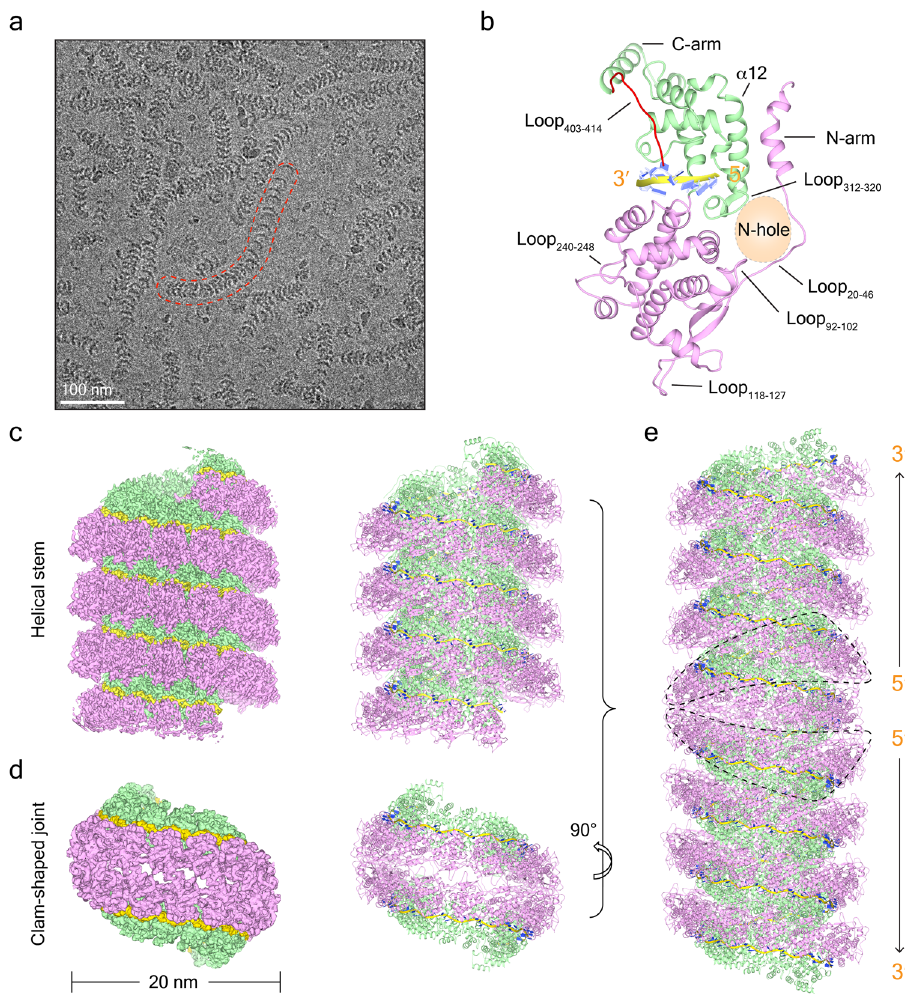
Fig. 1 Structure of double-headed SeV nucleocapsids. a A typical cryo-EM micrograph of double-headed SeV nucleocapsids. One curved SeV nucleocapsid with different assembly forms is highlighted in red. b The atomic model of one SeV nucleoprotein with the accompanied RNA. NTD and CTD are colored in pink and green, respectively. Loop 403 – 414 in N-tail is colored in red. N-hole formed by Loop 20 – 46 , Loop 92 – 102 , and Loop 312 – 320 is depicted in light orange. RNA is depicted with the backbones in gold and the bases in blue. The same color code is used for the rest of the fi gures. c 3D reconstruction of the helical stem of double-headed SeV nucleocapsids and the respective atomic model. d 3D reconstruction of the clam-shaped joint of double-headed SeV nucleocapsids and the respective atomic model. e Pseudo-atomic model of the double-headed SeV nucleocapsid. The clam-shaped structure is depicted in a dashed line and the RNA direction of two embedded RNA strands is